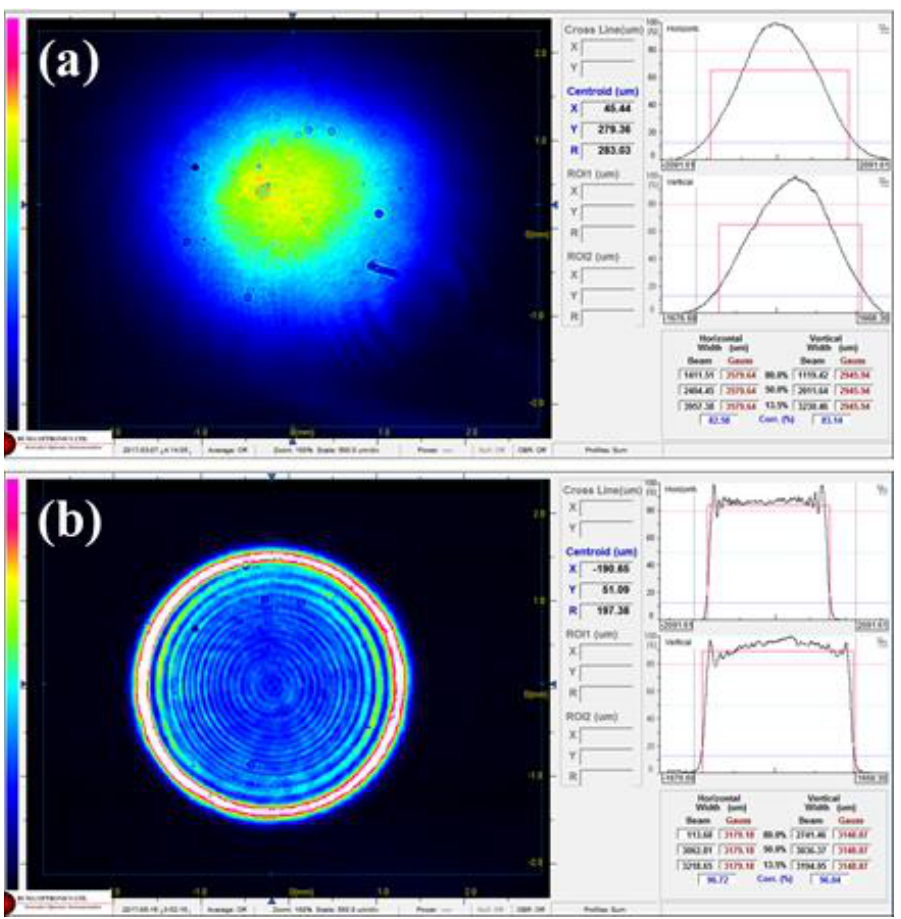
Figure 3. ( a ) Gaussian and ( b ) top-hat profile of the 355 nm UV laser measured by a beam profiler.